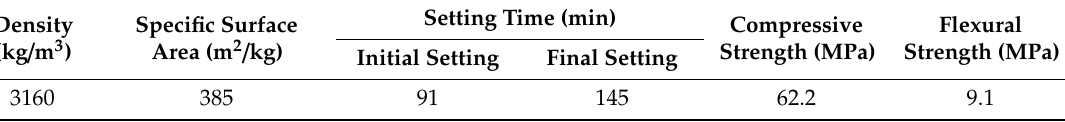
Table 1. The physical and mechanical properties of cement.